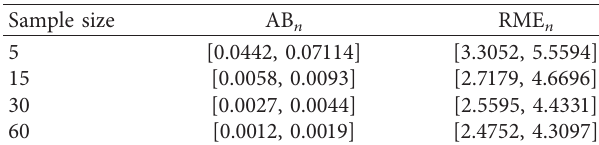
Table 1: Performance of likelihood estimates for the distributional parameters of